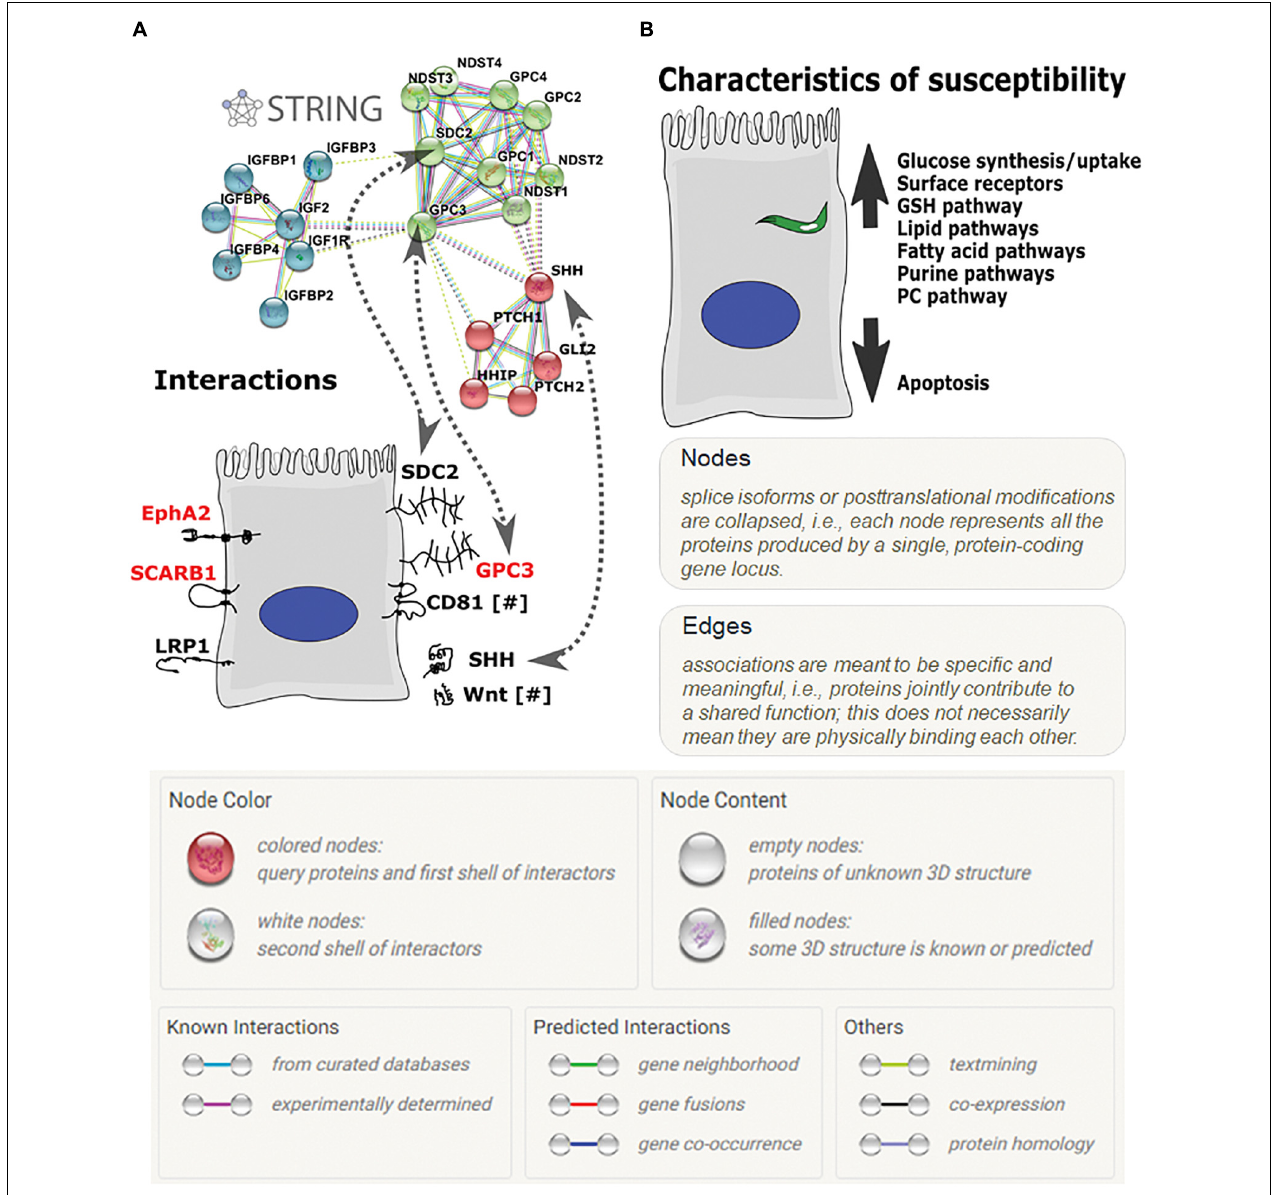
FIGURE 5 | Hepatocyte receptors and pathways involved in P. falciparum sporozoite invasion. (A) The glypican-3 (GPC3) STRING protein–protein interaction network. Proteins on the right side of the hepatocyte include GPC3 and its known interactors; proteins on the left side are other hepatocyte receptors implicated in sporozoite invasion. [GPC, glypican; NDST, N -deacetylase/ N -sulfotransferase (heparan glucosaminyl); IGFBP, Insulin-like growth factor binding protein 4; IGF, insulin-like growth factor; IGF1R, Insulin-like growth factor 1 receptor; PTCH, patched; HHP, Hedgehog interacting protein; GLI2, GLI family zinc finger 2; purple lines—experimentally determined interactors; light blue lines—curated database-determined interactors; light green lines—text mining-determined interactors; black lines—co-expression-determined interactors]. (B) Characteristics of a more-susceptible hepatocyte for P. falciparum invasion based on proteomic and transcriptomic